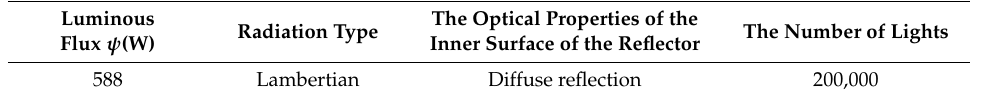
Table 3. TracePro simulation parameter settings.